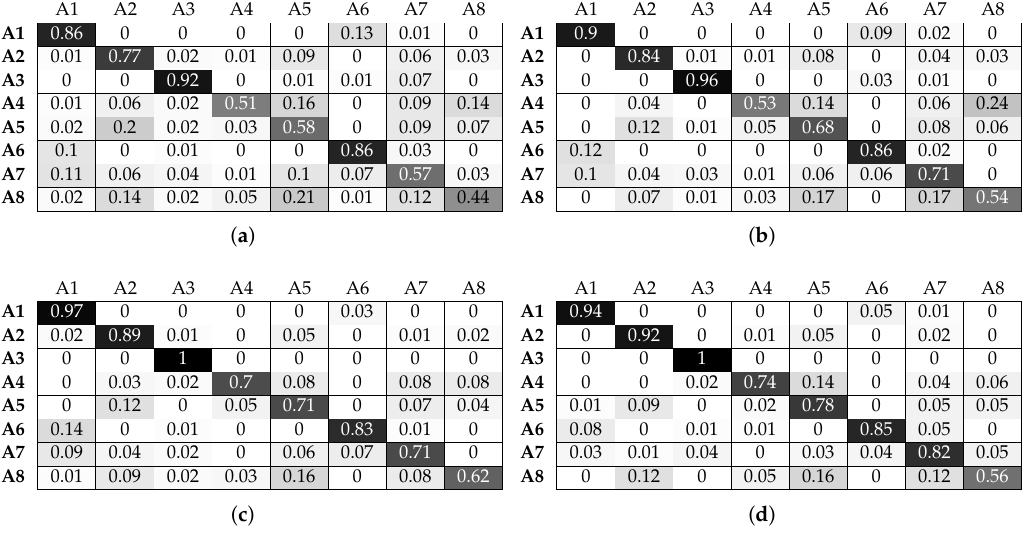
Figure 12. Normalised confusion matrices for KNN, with Wearable Feature Type 2, without beacon data. ( a ) n = 9, w = 1 s; ( b ) n = 10, w = 2 s ; ( c ) n = 8, w = 3 s; ( d ) n = 5, w = 4 s.